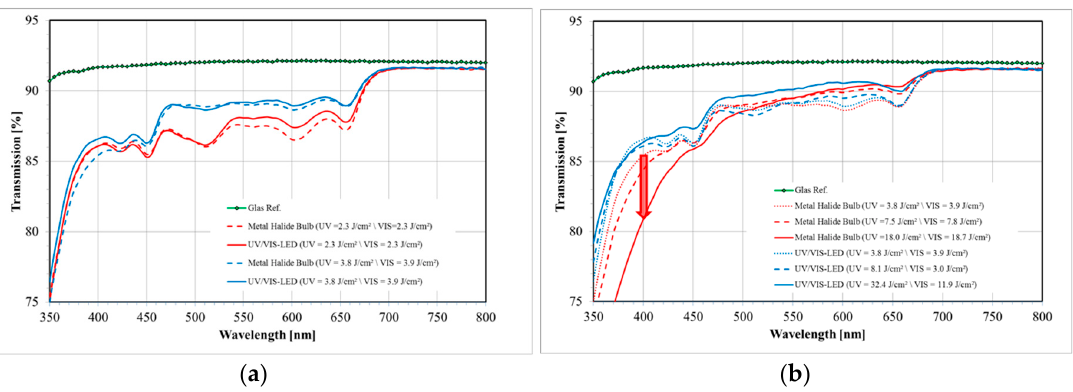
Figure 17. Comparison of bleaching results in which a metal halide bulb and a UV LED and VIS LED combination are used. ( a ) For the same dosage the performance of both curing systems is similar. Moreover, a higher dosage usually gives a better bleaching result; ( b ) Yellowing effect: due to the UV-B part of the metal halide bulb (cf. Figure 16) the transparency in the deep blue (black arrow) is significantly decreased. This effect is not apparent if the UV LED and VIS LED combination is used since this bleaching unit only has a single UV line radiation spectrum at 365 ± 5 nm [56].